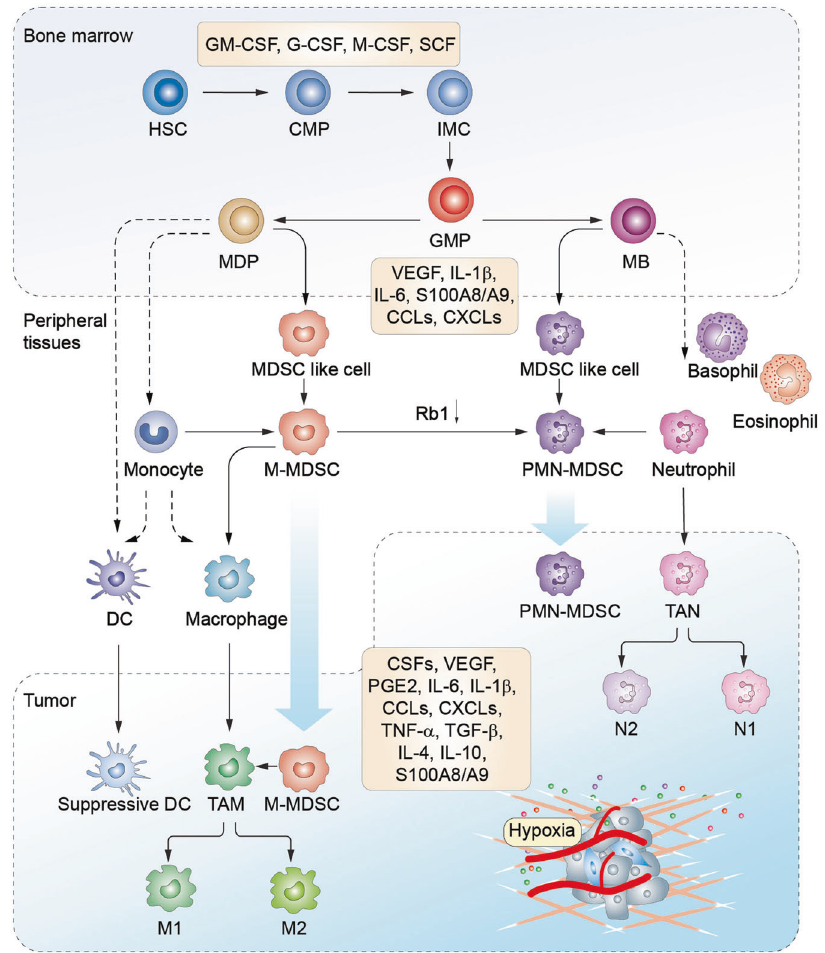
Fig. 2 Schematic diagram of MDSCs development, recruitment, and differentiation. In the bone marrow (BM), hematopoietic stem cells (HSCs)-derived common myeloid progenitors (CMPs) give rise to granulocyte-macrophage progenitors (GMPs) expansion. GMPs further differentiate into macrophage/dendritic cell progenitors (MDPs) and myeloblasts (MBs). This myelopoiesis process is controlled by growth factors such as GM-CSF, G-CSF, M-CSF, and SCF, etc. In normal physiological condition, as illustrated with the dotted line, MDPs further increase and are converted to macrophages and dendritic cells (DCs). MBs are further converted to granulocytes including basophils, eosinophils, and neutrophils. Under cancer conditions, lager population of immature myeloid cells (IMCs) are pathologically activated and then differentiate into M-MDSCs and PMN-MDSCs in the presence of tumor-derived factors such as VEGF, IL-6, and IL-1 β , etc. In early tumor stages, cells with similar biochemical features as MDSCs do not have suppressive activity, and are reffered as MDSC-like cells. MDSCs may also arise partially from reprogramming of the existing differentiated monocytes and polymorphonuclear cells. M-MDSCs can differentiate into PMN-MDSCs through transcriptional silencing of the retinoblastoma gene (Rb1). MDSCs are recruited into peripheral tissues and tumor